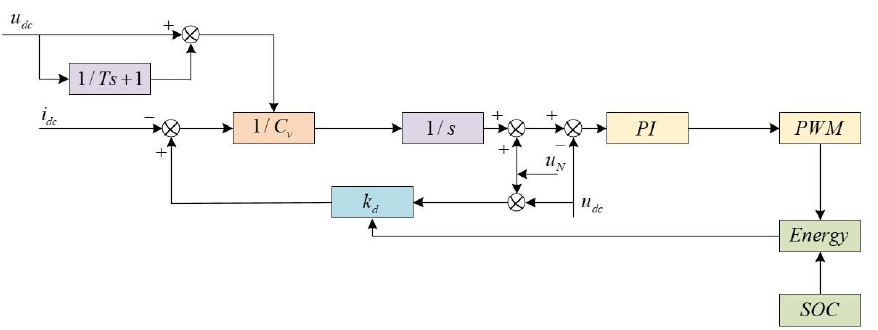
Figure 5. VSG SOC Power Distribution Control Block